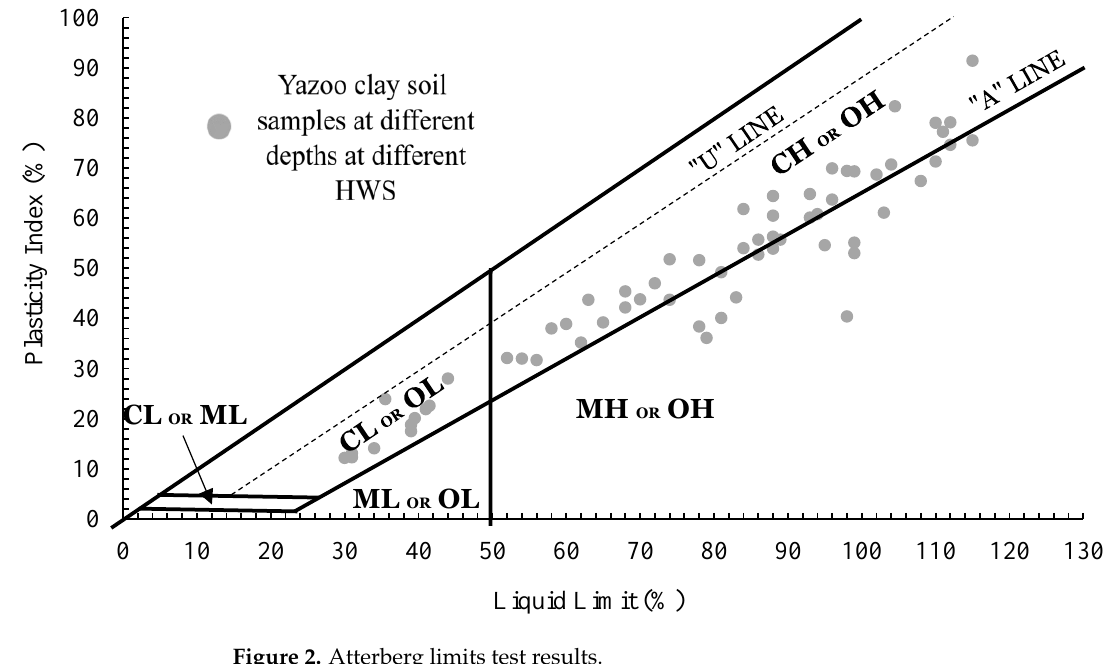
Figure 2. Atterberg limits test results.